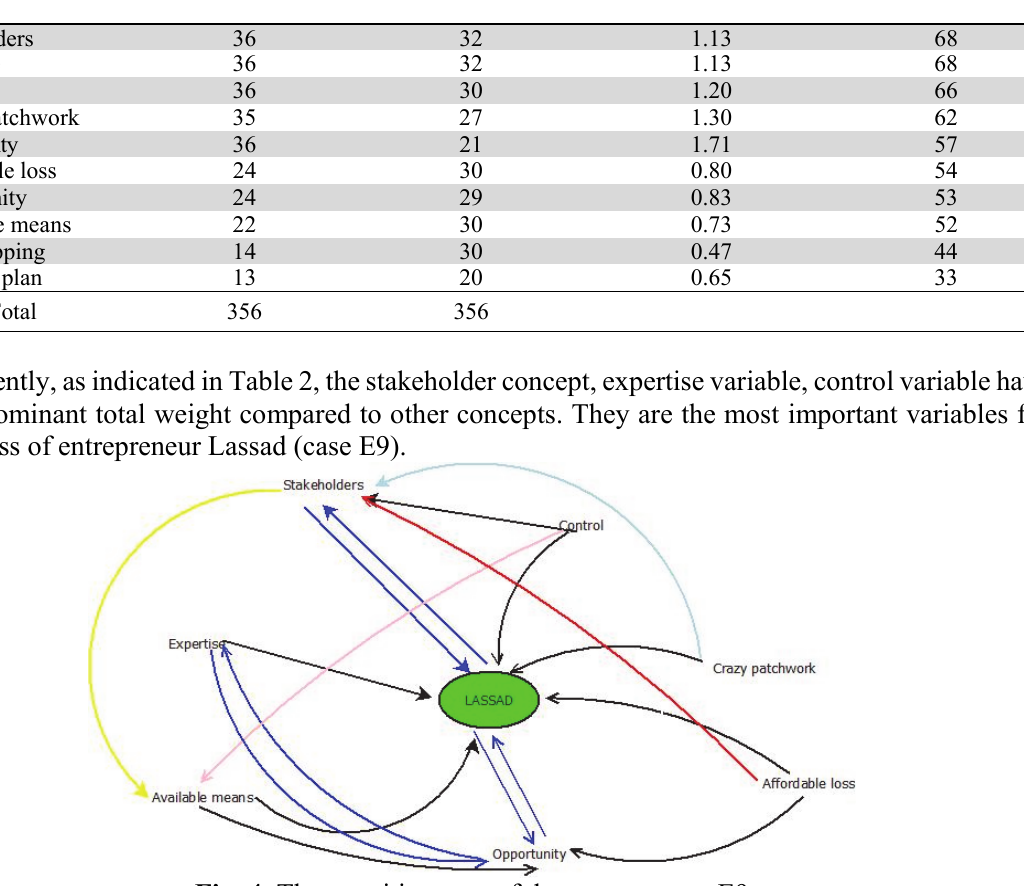
Fig. 4. The cognitive map of the entrepreneur